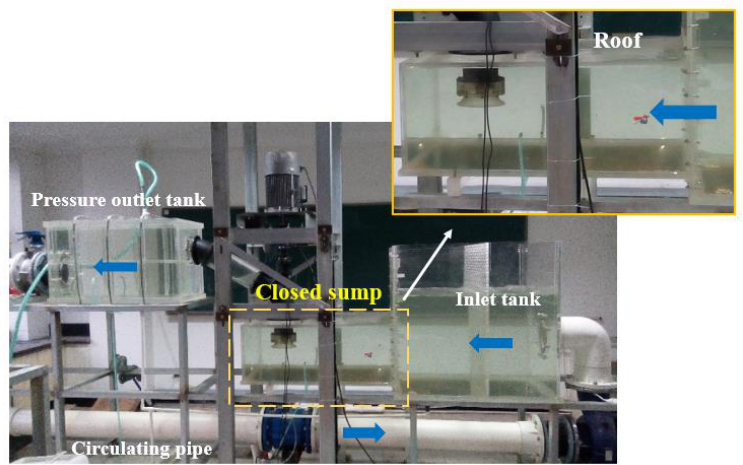
Figure 8. Circulating experimental device of the closed sump model.